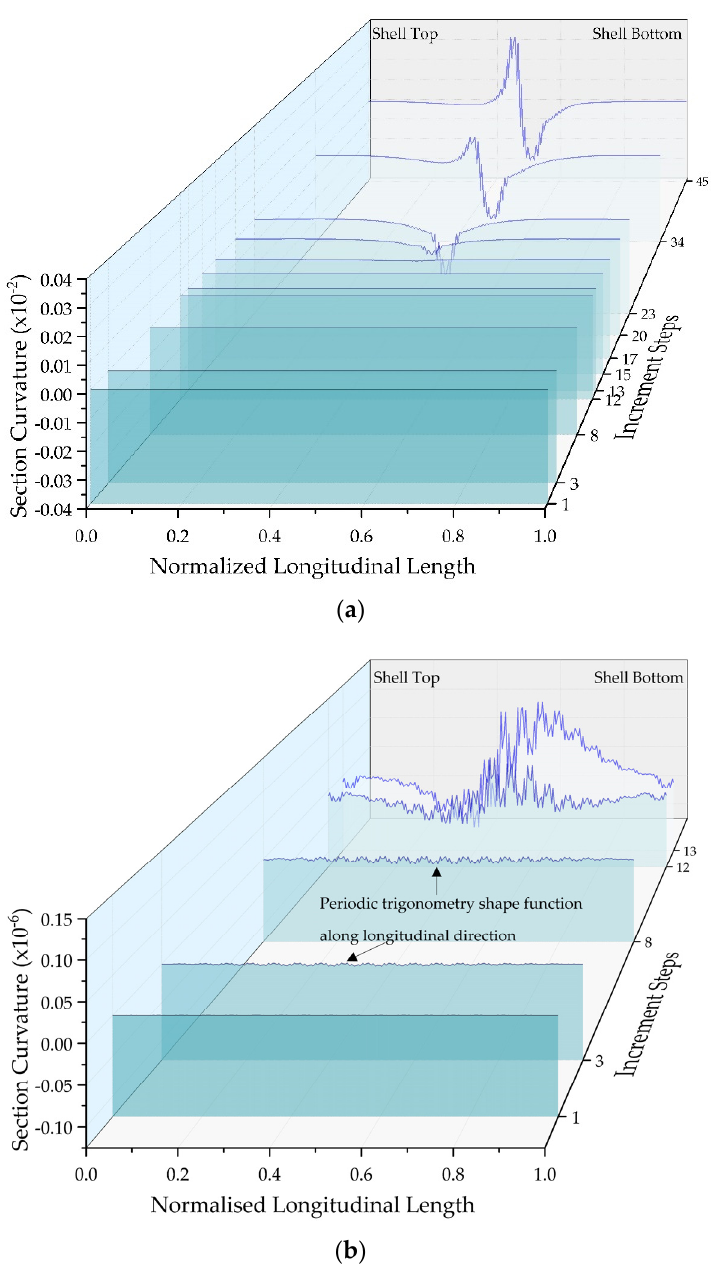
Figure 23. Shell (20 m at 24 mm) section curvature along the normalised longitudinal length under combined loads, ( a ) at typical increment steps and ( b ) partially enlarged at early increment steps. On the other hand, the circumferential strain energy and evolution is shown in Figure 24. The transition from smooth to highly asymmetric curves seen along the length of the shell replicated along the circumference, however the distribution of strain varied radically between the short and long tubes. In general, the strain distribution seems step-like for the short tube segment (Figure 24a) while for the long segment, these appeared to concentrate in specific points (peaks).